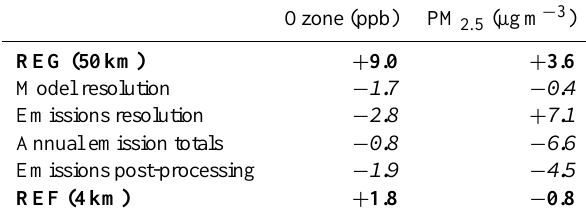
Table 4. The top row presents the coarse resolution application (REG) model bias of the April–August average urban ozone and wintertime urban PM 2 . 5 . Subsequently, marked with italics the sig- nals – measured as the absolute concentration change from REG – of several refinements such as increase of resolution (model or emissions) and adaptation of annual quantified fluxes and post- processing of a bottom-up inventory. The individual signals sum up to the absolute bias found under the fine resolution simulation (REF). Ozone (ppb) PM 2 . 5 (µgm − 3 ) REG (50km) + 9.0 + 3.6 Model resolution − 1.7 − 0.4 Emissions resolution − 2.8 + 7.1 Annual emission totals − 0.8 − 6.6 Emissions post-processing − 1.9 − 4.5 REF (4km) + 1.8 −